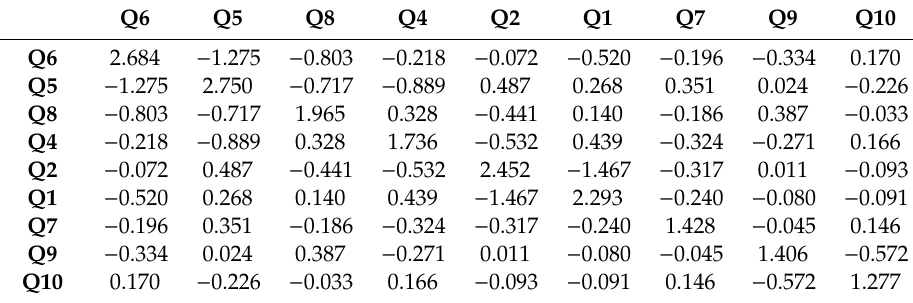
Table A1. Inverse of Correlation Matrix (N =